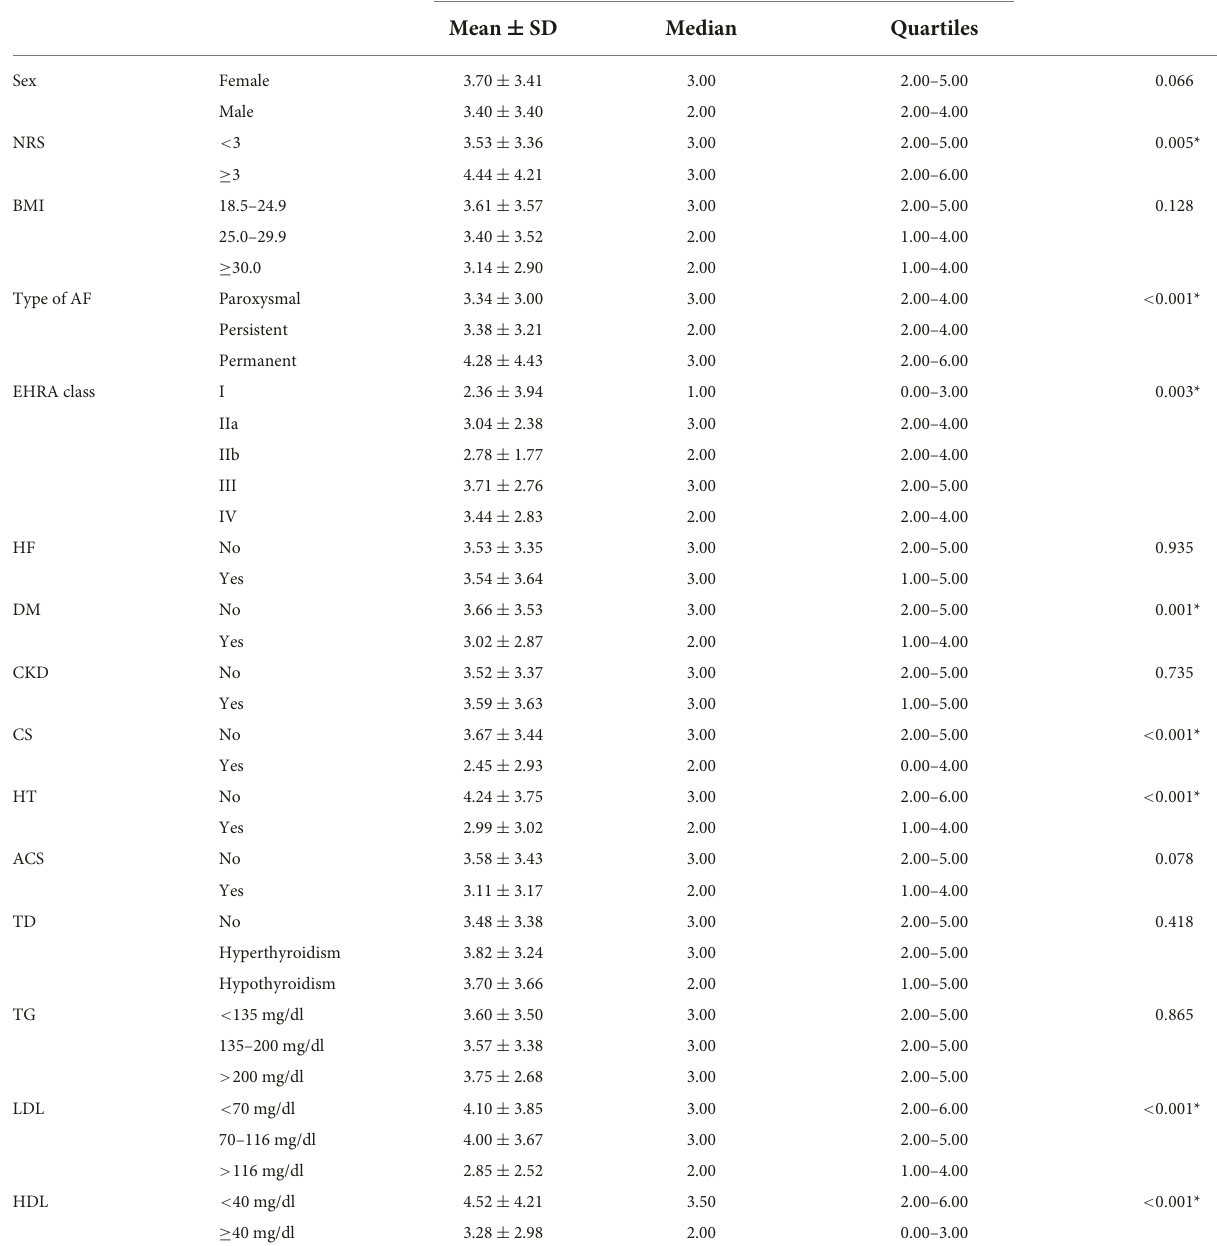
TABLE 4 Length of hospital stay across groups (qualitative variables): Univariate